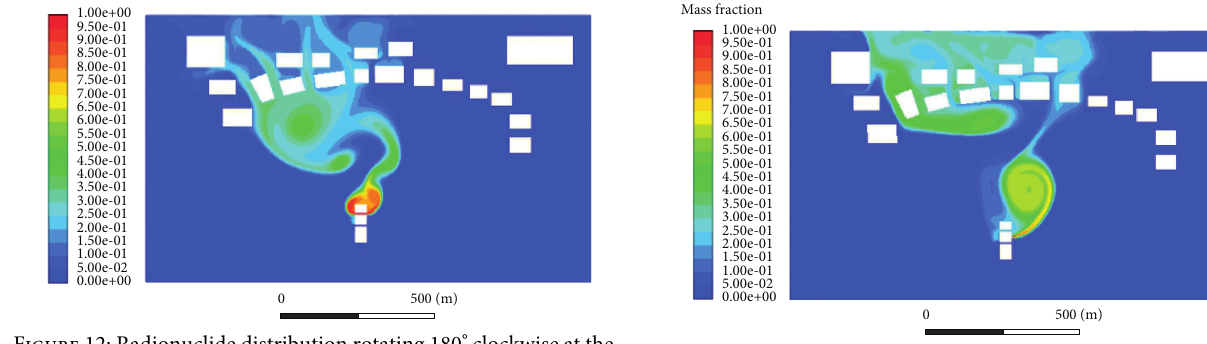
Figure 15: Radionuclide distribution rotating 180 ° clockwise at the western break.